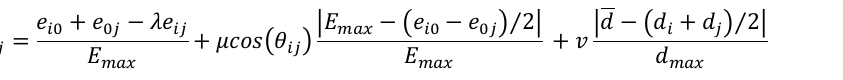
Algorithm 1. Heuristic algorithm adapted from Bernal et al.,